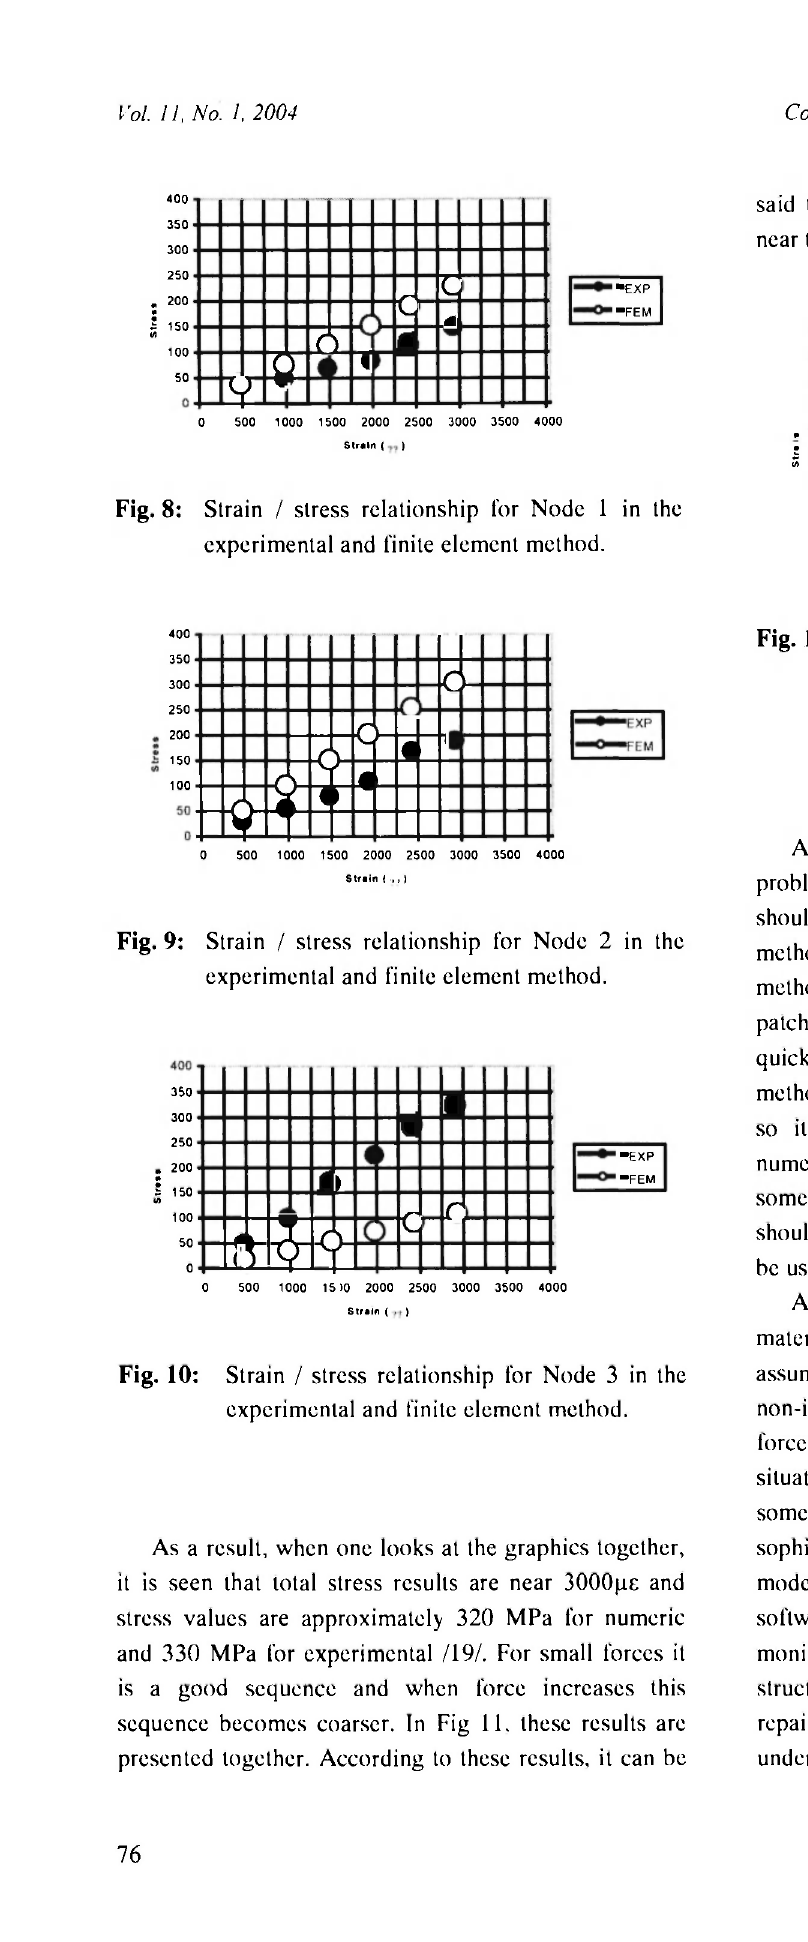
Fig. 8: Strain / stress relationship for Node 1 in the experimental and finite element method.